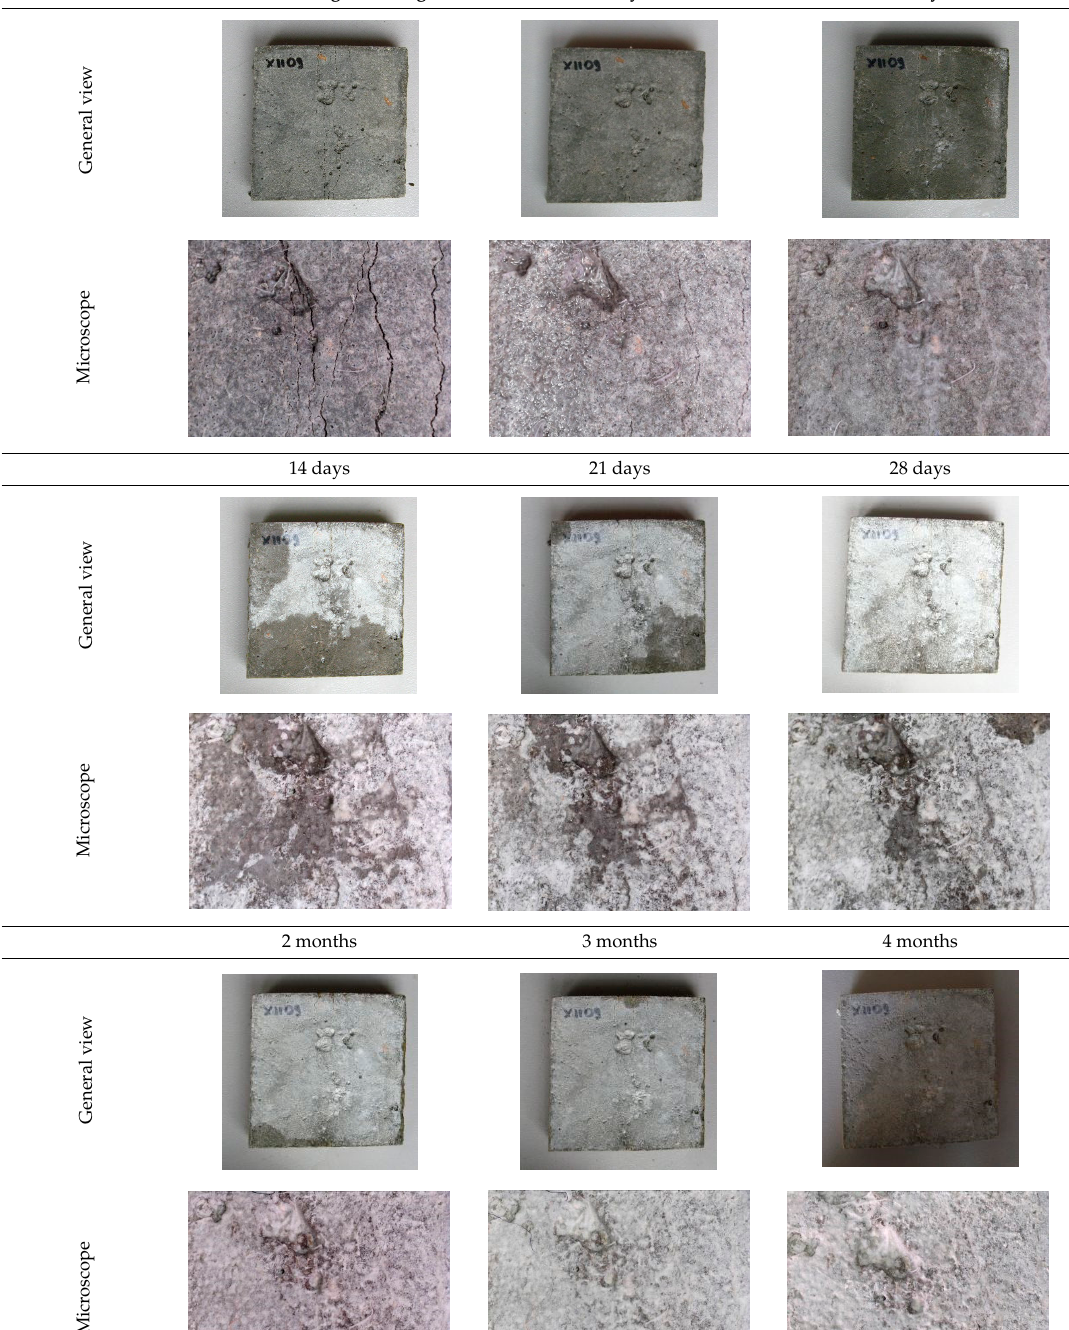
Table 7. Crack development of one test specimen during the second phase. After Finishing of Curing 0 Days 7